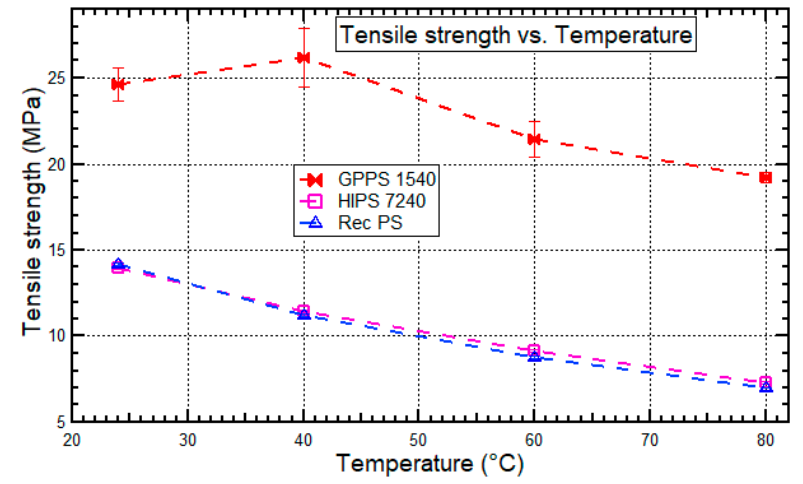
◦ C, 40 ◦ C, 60 ◦ C, and 80 ◦